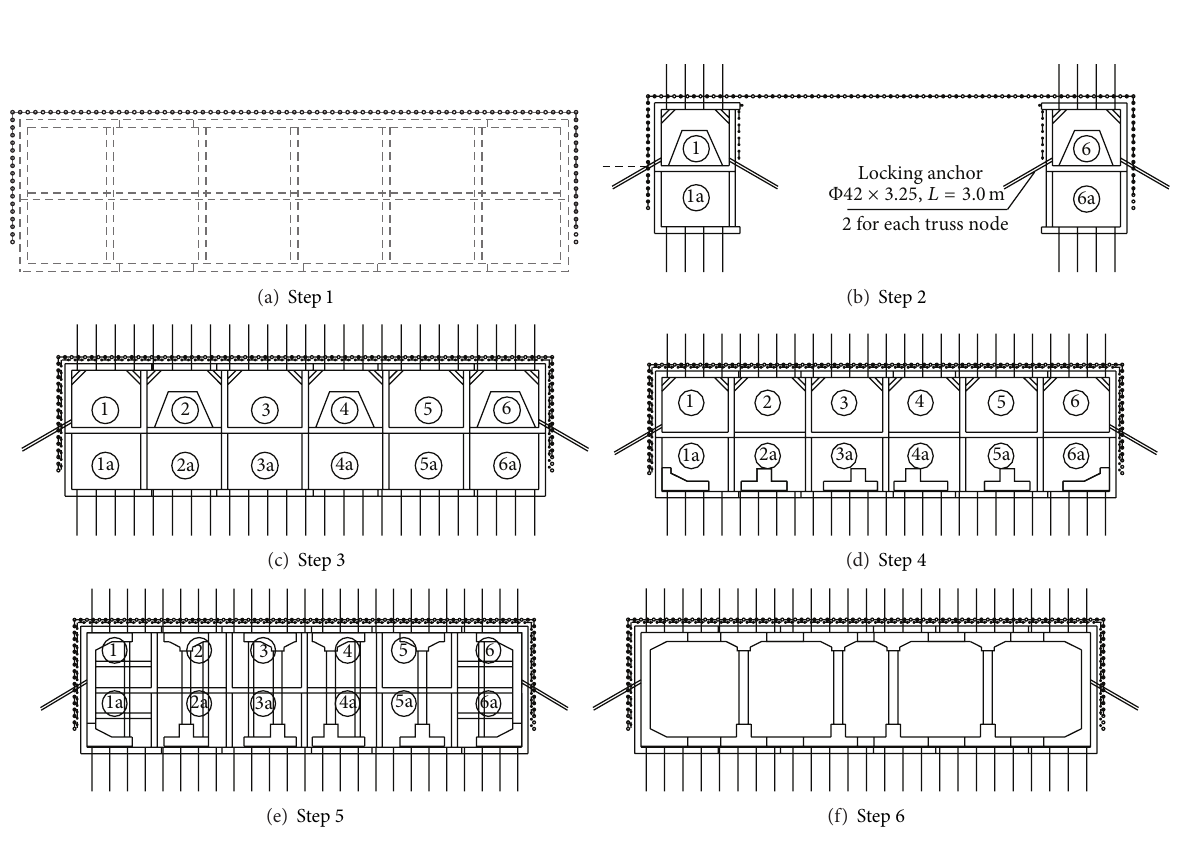
Figure 6: Flow chart of construction method.